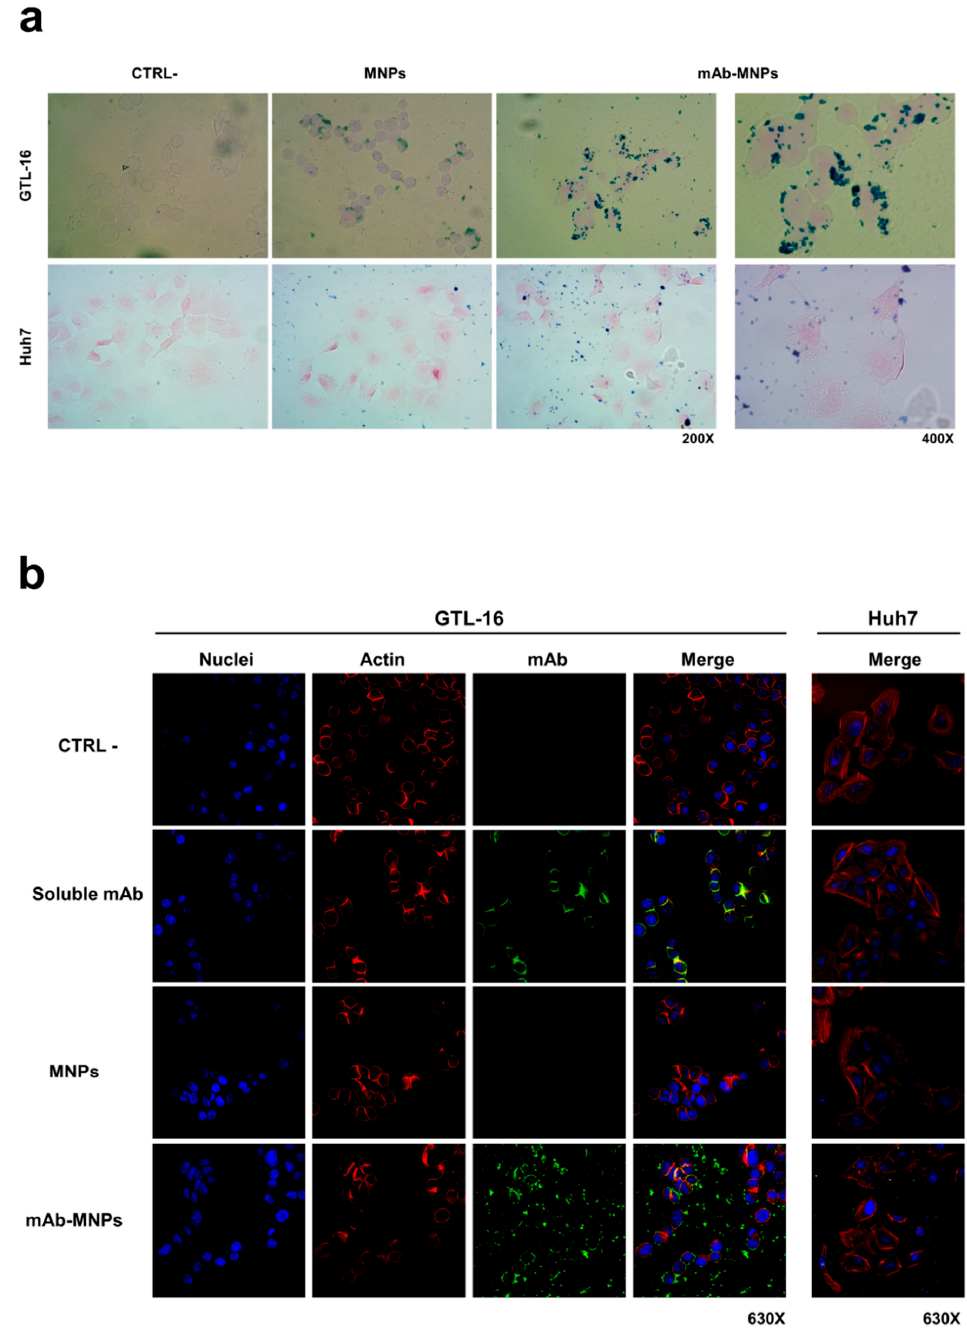
Figure 8. Interaction of mAb-functionalized magnetic nanoparticles with cells. GTL-16 and Huh7 cells were incubated with MNPs, functionalized or not with the DO-24 mAb ( a ) and ( b ), as well as with soluble mAb ( b ) for 2 h at 37 °C. After washing, staining was performed with Prussian blue ( a ); the first three panels on the left are 200× magnification and the forth on the right is 400× magnification for both cell types) or with FITC-labelled anti-mouse Ig (green), TRITC-labelled falloidin (red), TO-PRO3 (blue) to label the DO-24 mAb, the cytoskeletal actin and nuclei, respectively ( b ). Images were then merged. CTRL − , control untreated cells.